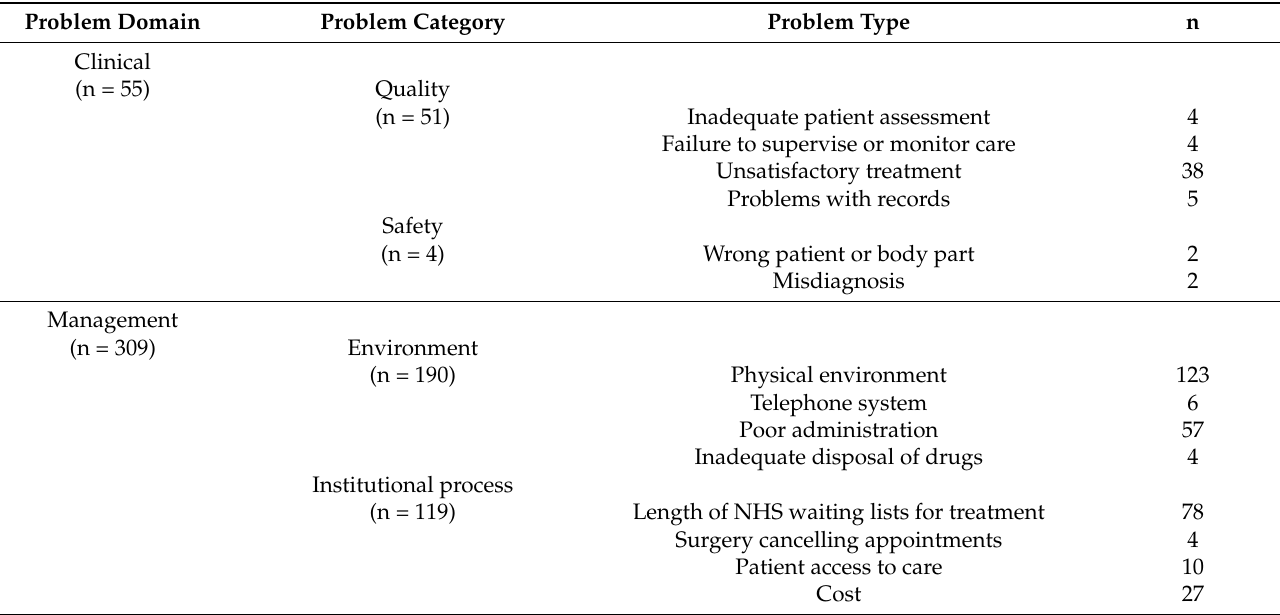
Table 1. Distribution of patient complaints using the healthcare complaints analysis tool domains and problems (n =